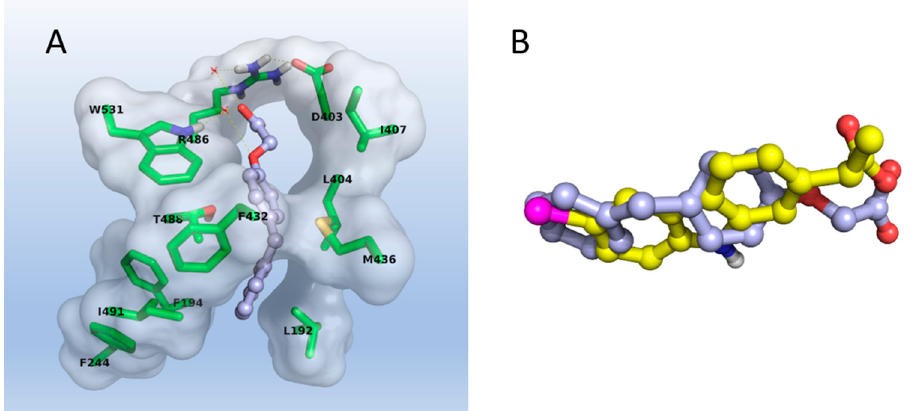
Figure 3. ( A ): docking pose of compound 5 . ( B ): molecular superposition with carprofen (yellow carbons).